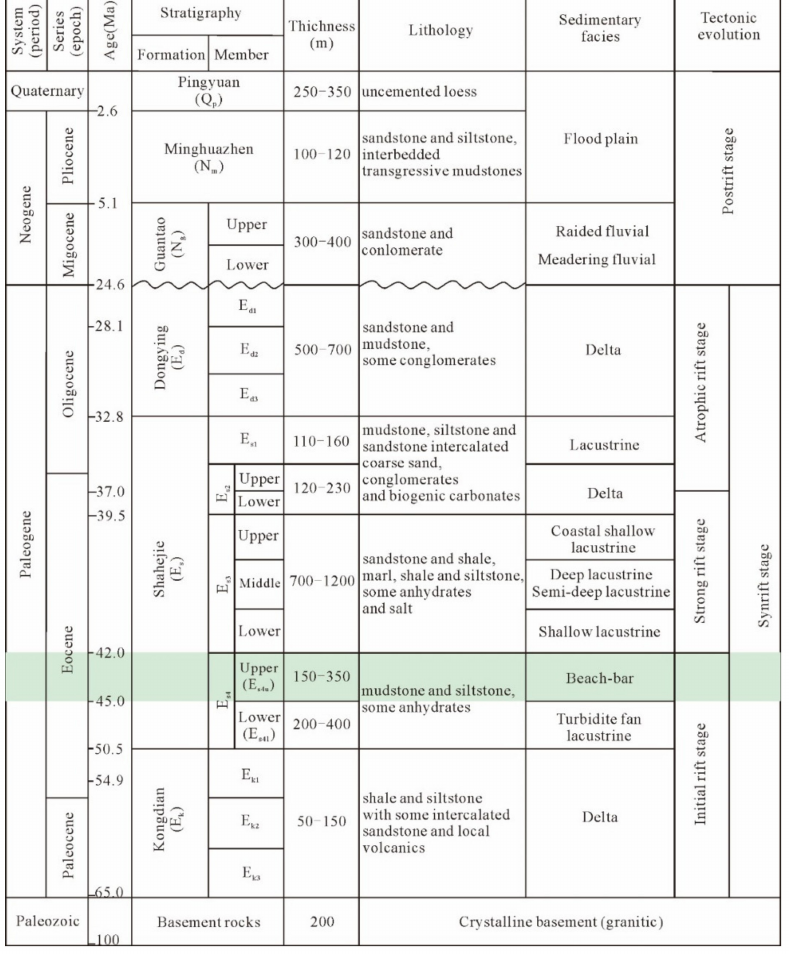
Figure A1. Schematic Tertiary stratigraphy and tectonic evolution in the Dongying